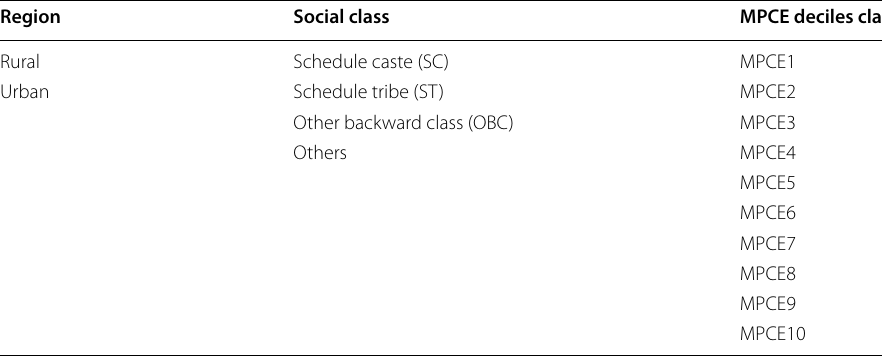
Table 4 List of indicators to classify